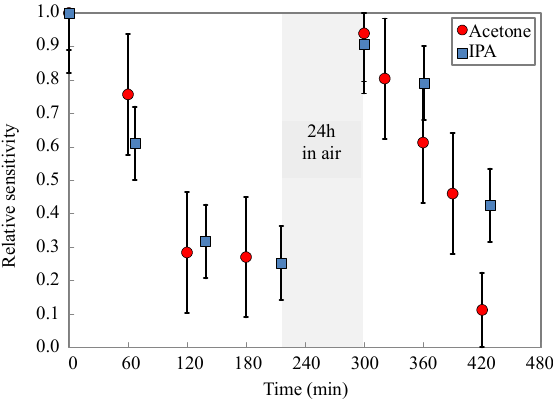
Fig. 7 Relative sensitivity of MZI waveguide device time when subjected to continuous acetone / N 2 ( C = 13.29%) and IPA / N 2 flow ( C = 3.06%)